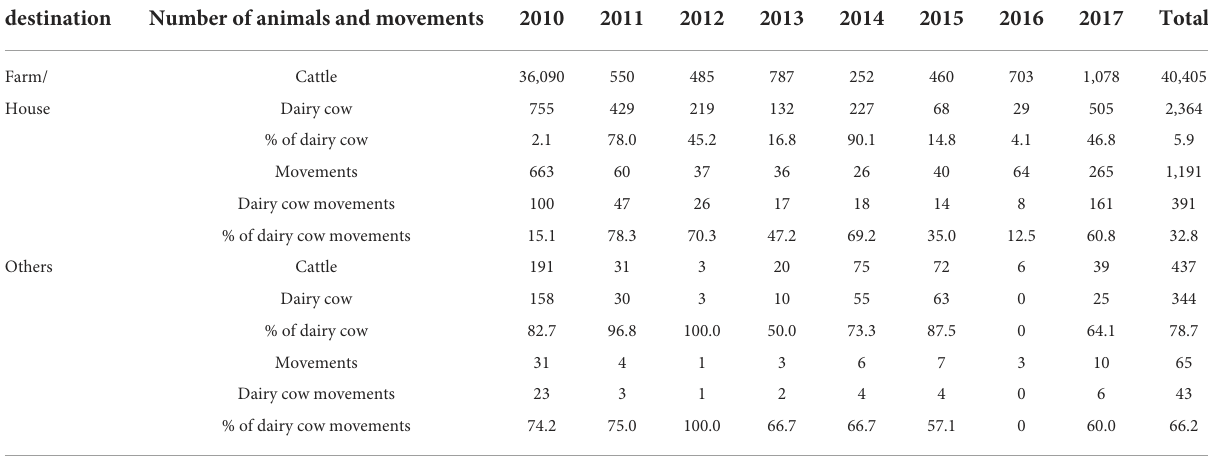
TABLE 6 Number of dairy cows moved (animal head) among the total cattle moved (animal head) and their corresponding movements (frequency) by types of premises of destination other than abattoirs in northern Thailand from 2010 to 2017. Premises of destination Number of animals and movements